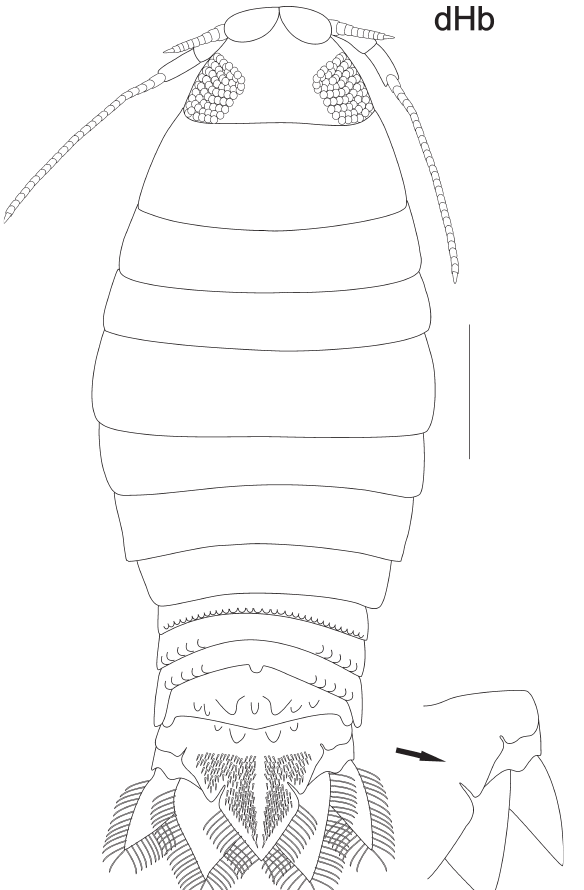
Figure 13. Excorallana subtilis (Hansen, 1890), female, 6 mm. (MOUFPE 13.012), habitus. Detail showing smooth area, without tubercles, prior to lateral incision. Scale= 1 mm.